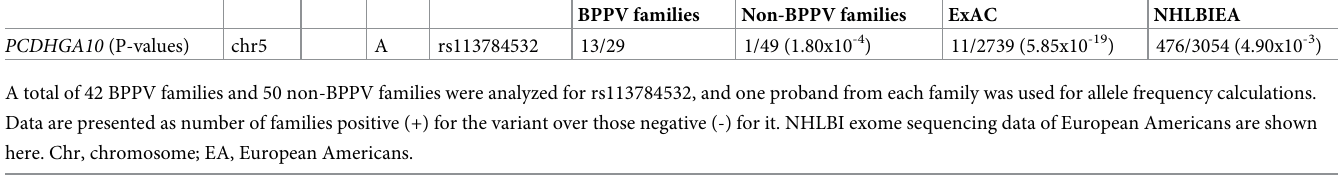
with definitive information on onset ages were tallied) years old among those with the variant as compared with 54.4 ± 16.1 (n = 36 tallied) years of onset age among those without (p = 0.054, S3 Table).